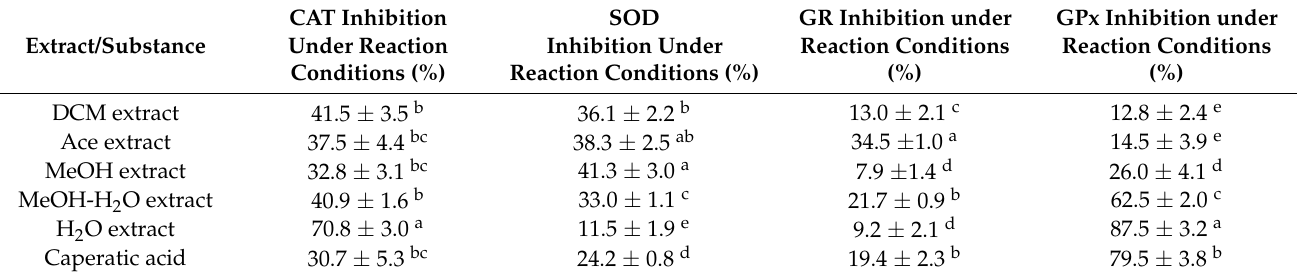
Table 5. Effect of lichen extracts and compounds on antioxidant enzymes.